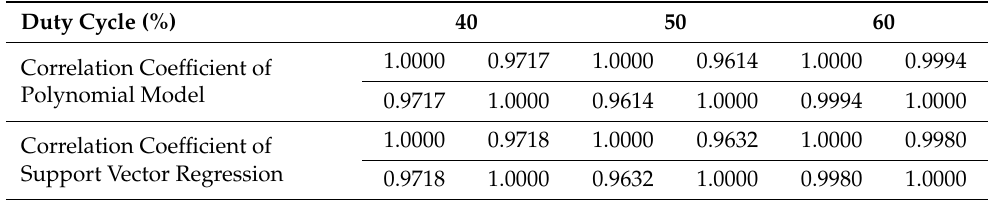
Table 9. Correlation coefficient at different duty cycles.